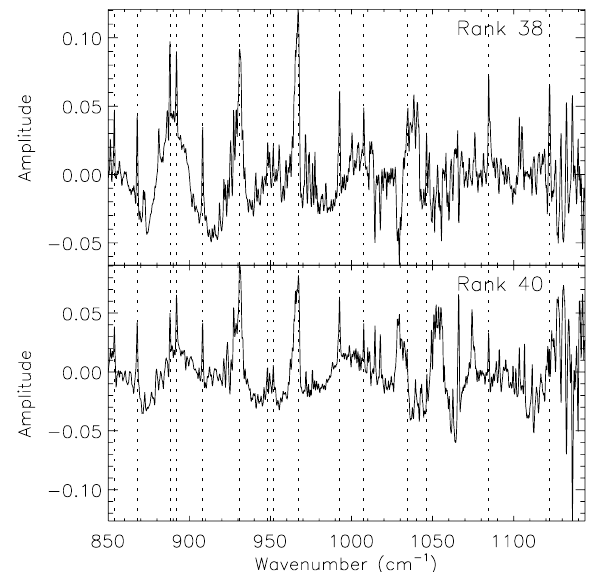
Fig. 4. Eigenvectors of rank 38 and 40 in IASI band 1. Both contain a strong signature of ammonia. Vertical lines mark the ammonia absorption lines, from Clarisse et al.